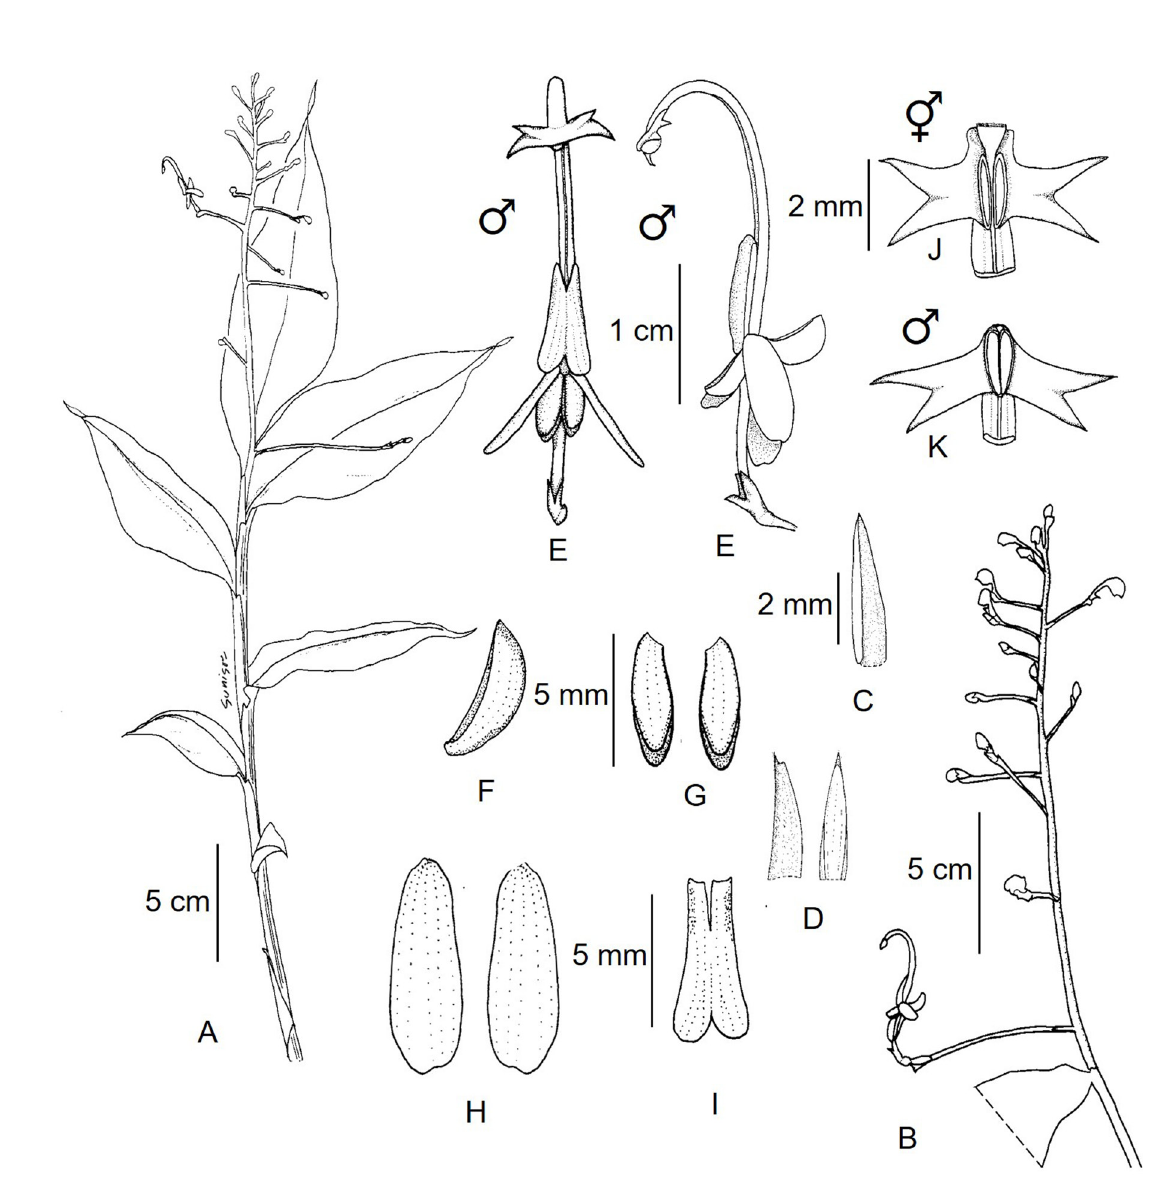
Fig. 11. Globba lithophila Sangvir. & M.F.Newman sp. nov. A . Habit. B . Inflorescence. C . Bract. D . Bracteole, side and front views (same scale as C). E . Flower, front and side views. F . Dorsal corolla lobe. G . Lateral corolla lobes (same scale as F). H . Lateral staminodes. I . Labellum (same scale as H). J . c appendages. K . ♂ appendages (same scale as J). Drawing: S. Sangvirotjanapat from